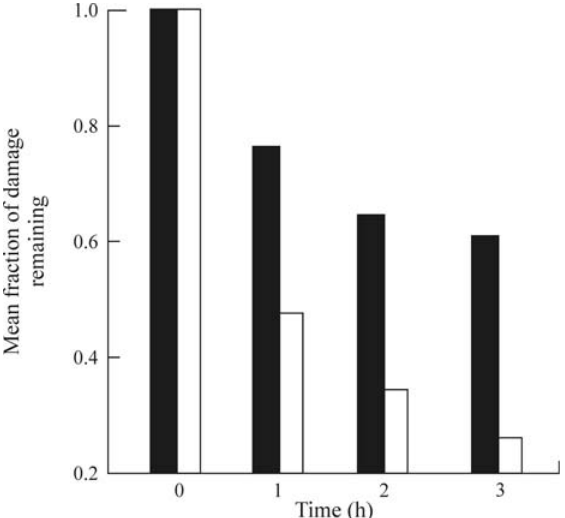
Figure 6 - DNA double-strand breaks rejoining in Chlamydomonas reinhardii CW15 after irradiation (500 Gy) in the presence ( ■ ) or absence ( ❏ ) of cycloheximide (10 μ L mL -1 ) in combination with chloramphenicol (100 μ L mL -1 ). Error bars are not visible because the standard error is too small. Modified from Chankova and Bryant